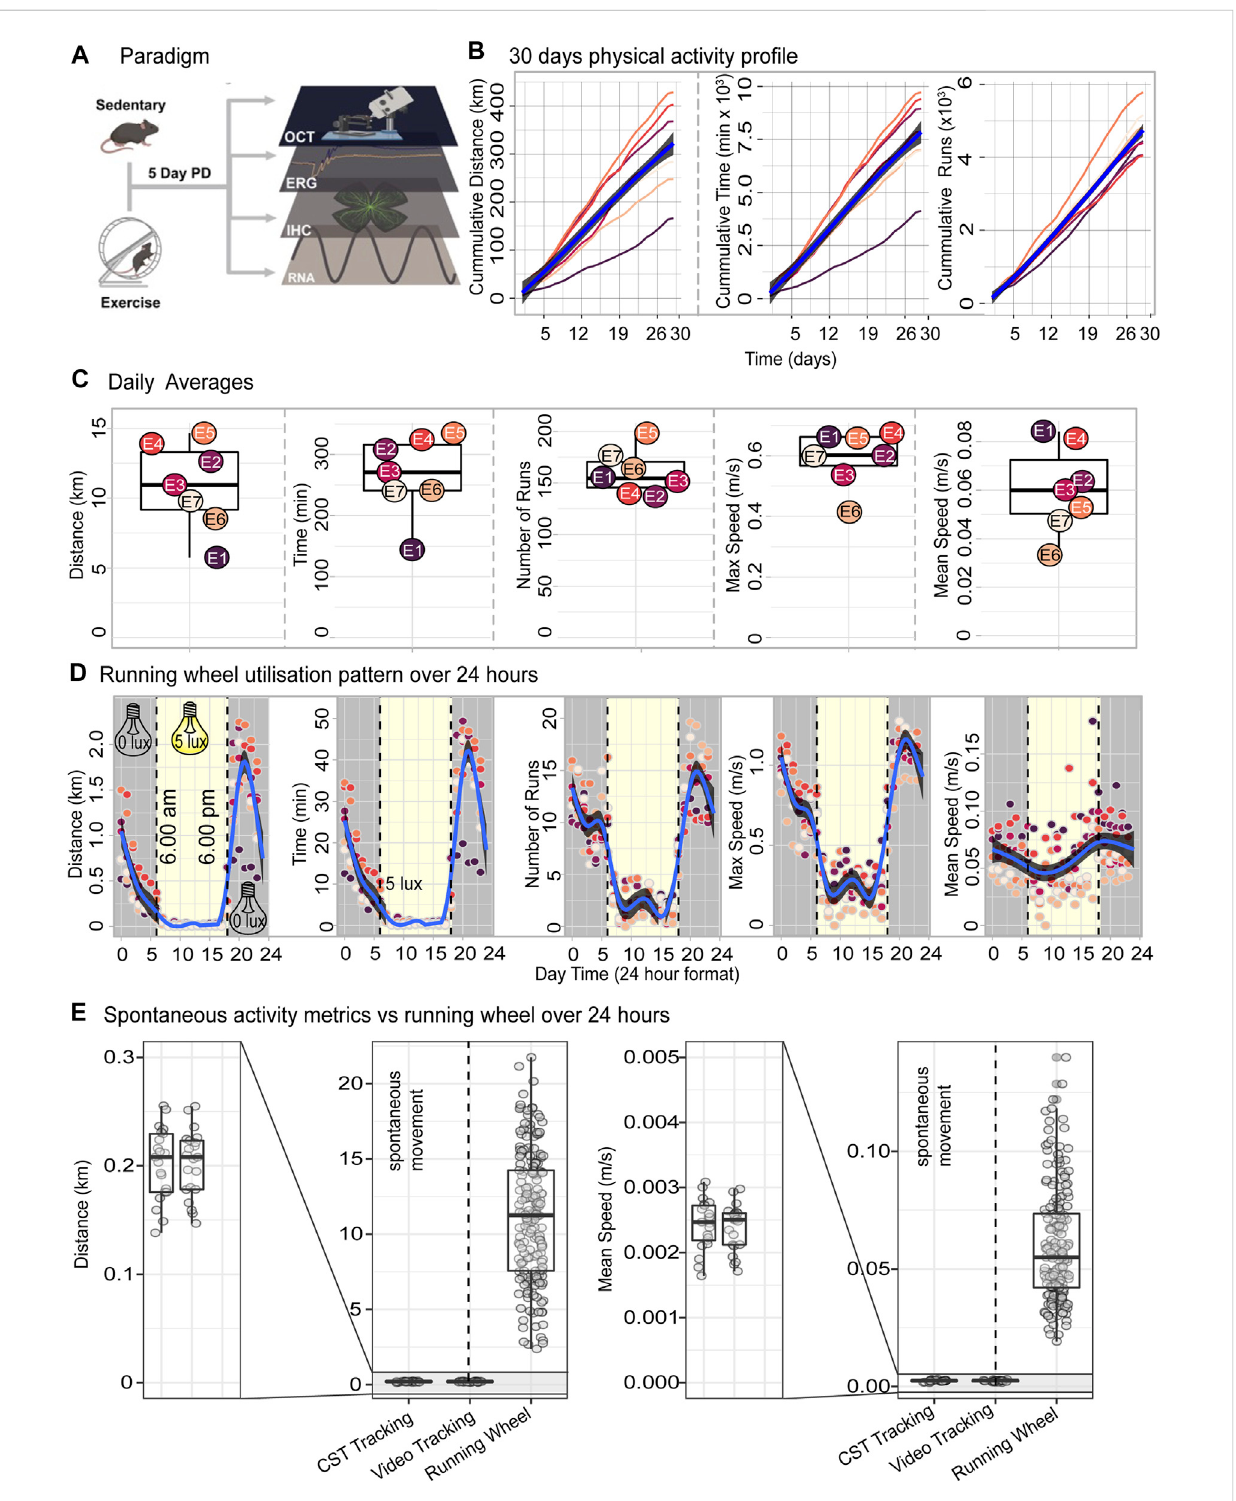
FIGURE 1 Voluntary exercise paradigm and daily running data outputs. (A) Schematic depicting voluntary exercise and degeneration paradigms, with output measures of retinal function, morphology and RNA sequencing. (B) Cumulative distance, time and runs made chronologically per animal. (C) Box-and- whisker graphs showing daily and average running wheel outputs: distance (km), time (mins), number of runs, max speed (m/s) and, average speed (m/s) across 28 days for each animal. Two days were omitted due to incomplete data recordings from required cage maintenance. (D) Utilisation of running wheel during the 12 h light/dark housing conditions. Blue lines show the trend in physical activity over 24 h summarised using a generalised additivemodel.Greyshadedareaindicatesthe95%con fi denceinterval. (E) Dailydistanceandmeanspeedresultingfromaccesstotherunningwheelsor spontaneous in-cage movement. n =